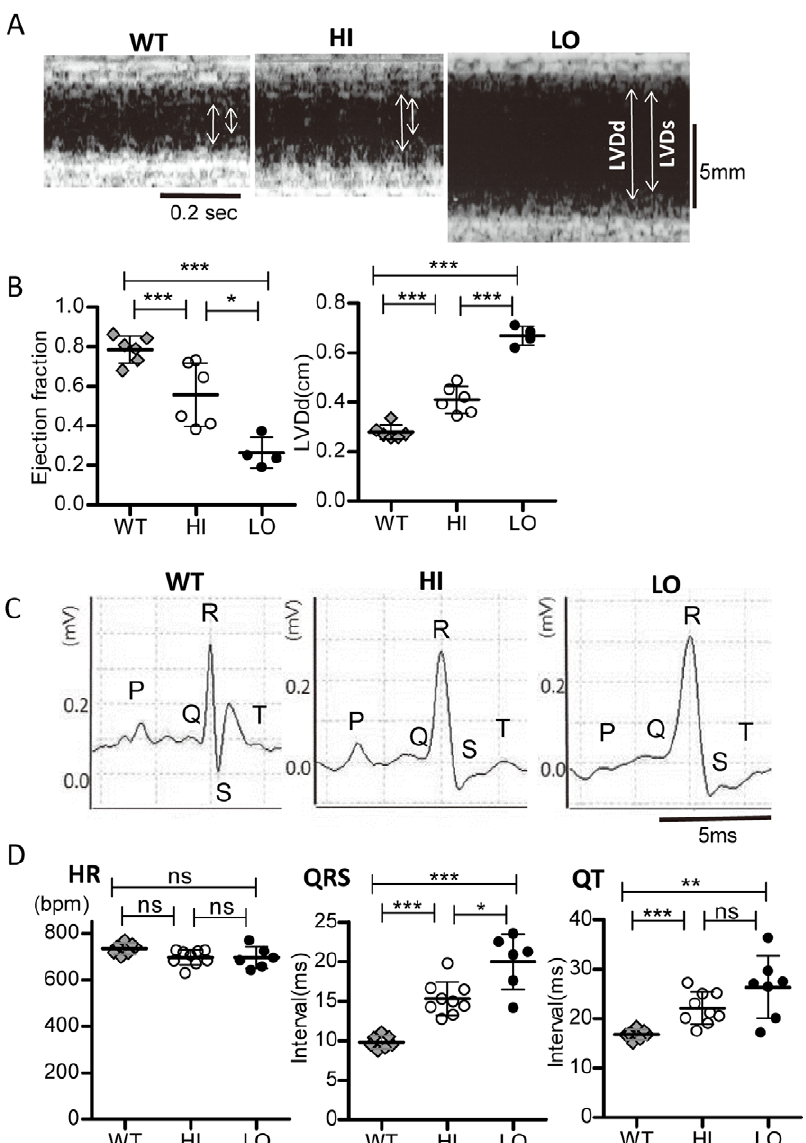
Figure 3. Echocardiography and ECG data from WT and DCM mice. A. Typical M-mode ultrasound cardiogram obtained from conscious WT and HI and LO DCM mice. B. Average LVDd (left) and EF (right). C . Typical ECG traces from WT and HI and LO DCM mice. D. Comparison of average heart rate (left), QRS (middle), and QT intervals (right) determined from conscious mice. Bars are mean 6 SD. *P , 0.05, **P , 0.01, ***P , 0.001; ns: not